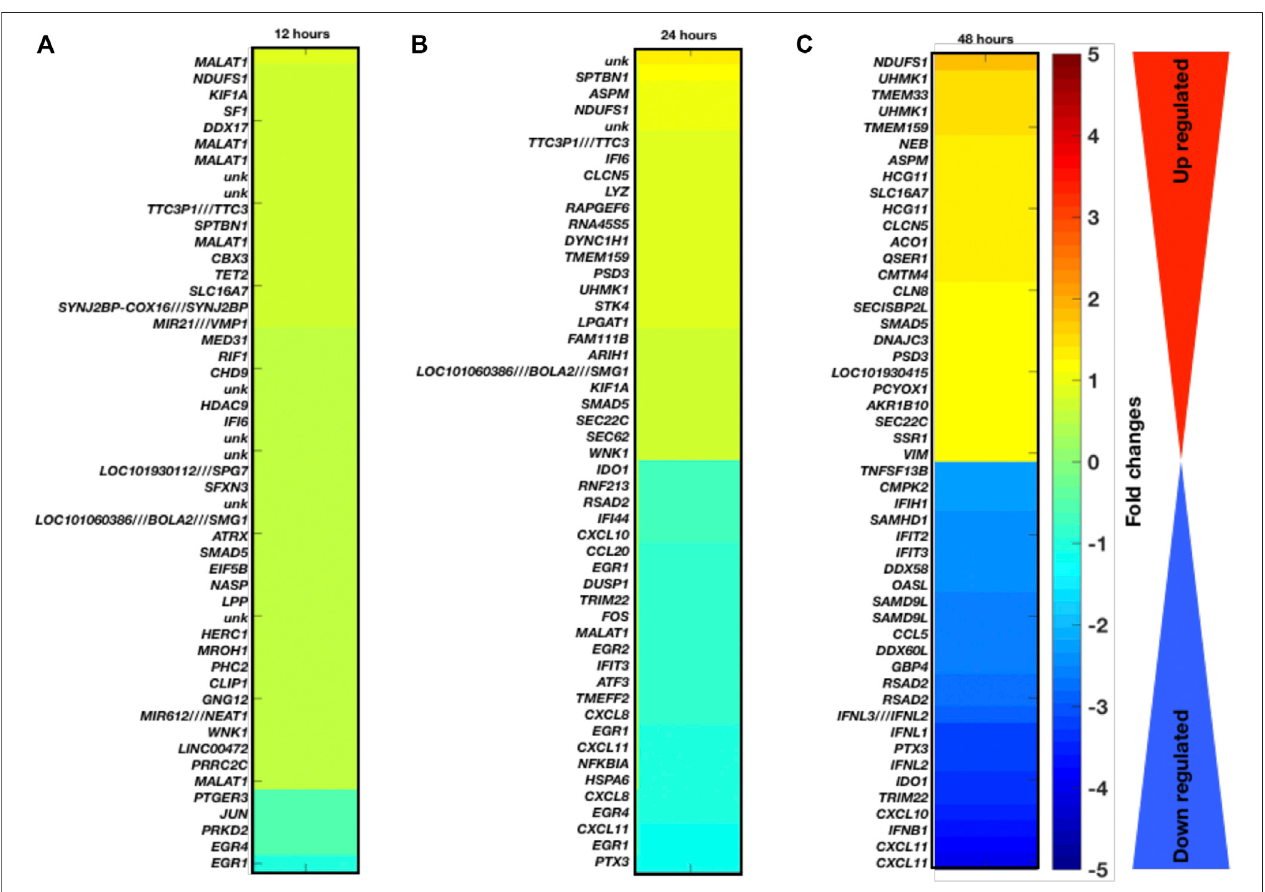
FIGURE1| Geneexpressionpro fi lingandenrichedpathways.Top-ranked50DGEsbasedonfoldchangesand p -valuesatdifferentinfectiontimeperiod (A) 12 h, (B) 24 h, and (C) 48 h.